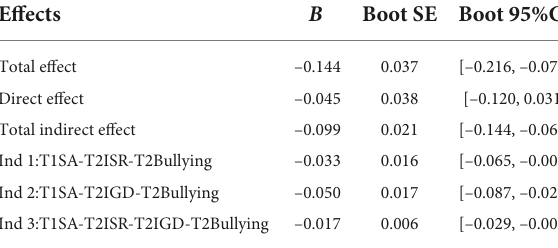
TABLE 4 Testing results of all pathways of the serial multiple mediation